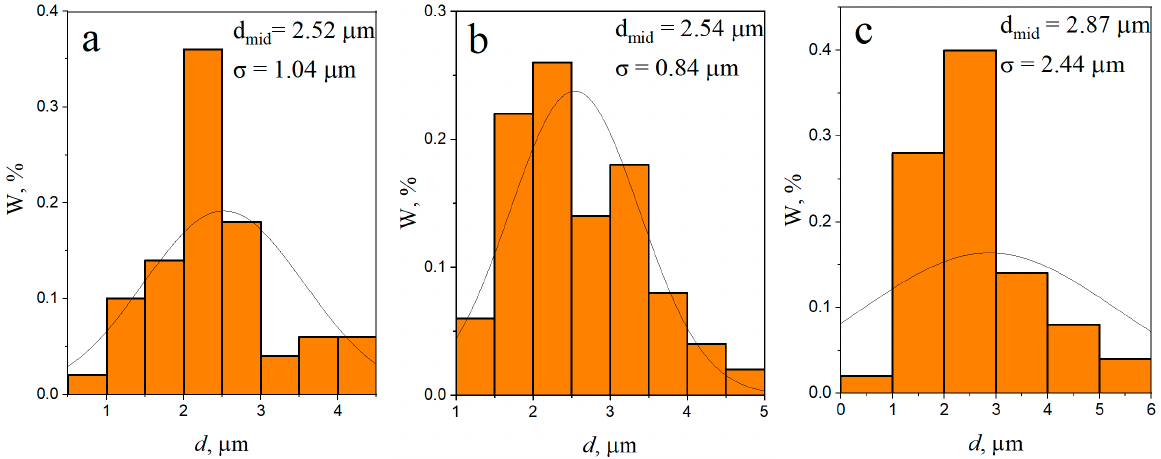
Figure 9. Average grain size and grain size distribution FSP-ed RPPs/AA5056 composite in the pro- cessing zone after 4 passes: ( a ) stir zone; ( b ) thermomechanically affected zone; ( c ) base metal.